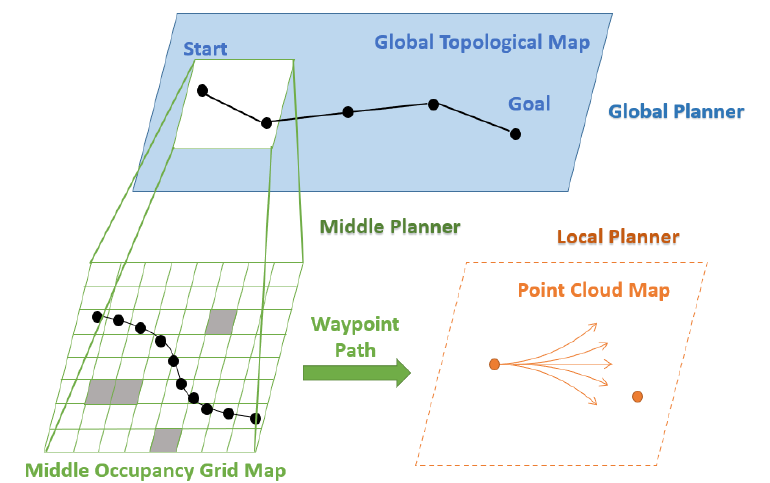
Figure 8. Planning